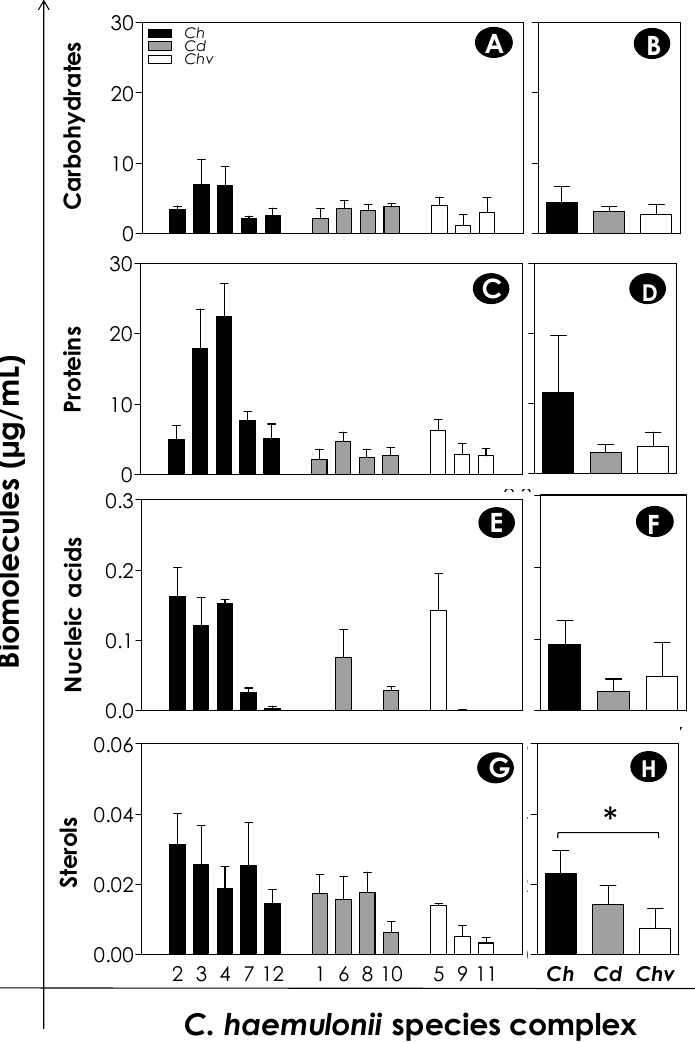
Figure 5. Main biomolecules forming the extracellular matrix (ECM) of the C. haemulonii species complex biofilms on polystyrene surface. Yeasts (200 µL containing 10 6 cells) were placed to interact with polystyrene for 48 h at 37 °C. After that, ECM was extracted and carbohydrates, proteins, nucleic acids, and sterols were quantified as detailed in methodology section. The results were expressed as concentration (µg/mL) of each biomolecule per clinical isolate studied ( A , C , E , and G ) and mean concentration per fungal species ( B , D , F , and H ). The results are shown as mean ± standard deviation of three independent experiments. The symbol (*) indicates p -values < 0.05 (one-way ANOVA, Tukey’s multiple comparison test). The numbers on the X-axis of graphs represent each of the 12 clinical isolates of the C. haemulonii complex studied, in which Ch means C. haemulonii , Cd means C. duobushaemulonii, and Chv means C. haemulonii var. vulnera .